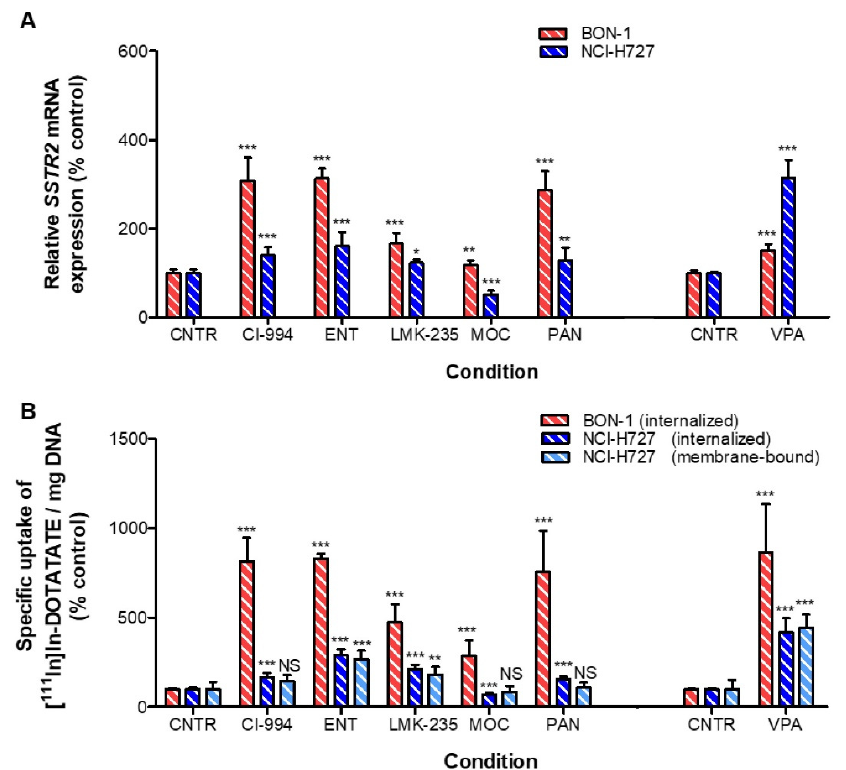
Figure 2. NET cells lines were treated for seven days with HDACis at the IC 50 dose, and subsequently analyzed by ( A ) RT ‐ qPCR ( SSTR2 mRNA) and ( B ) [ 111 In]In ‐ DOTATATE uptake studies. For uptake studies, DNA was quantified to correct for differences in cell number at the start of the assay. Membrane ‐ bound fractions for BON ‐ 1 are not shown as values were too low for accurate measurement. Results were normalized to vehicle ‐ treated cells. * p < 0.05, ** p < 0.01, *** p < 0.001, NS; non ‐